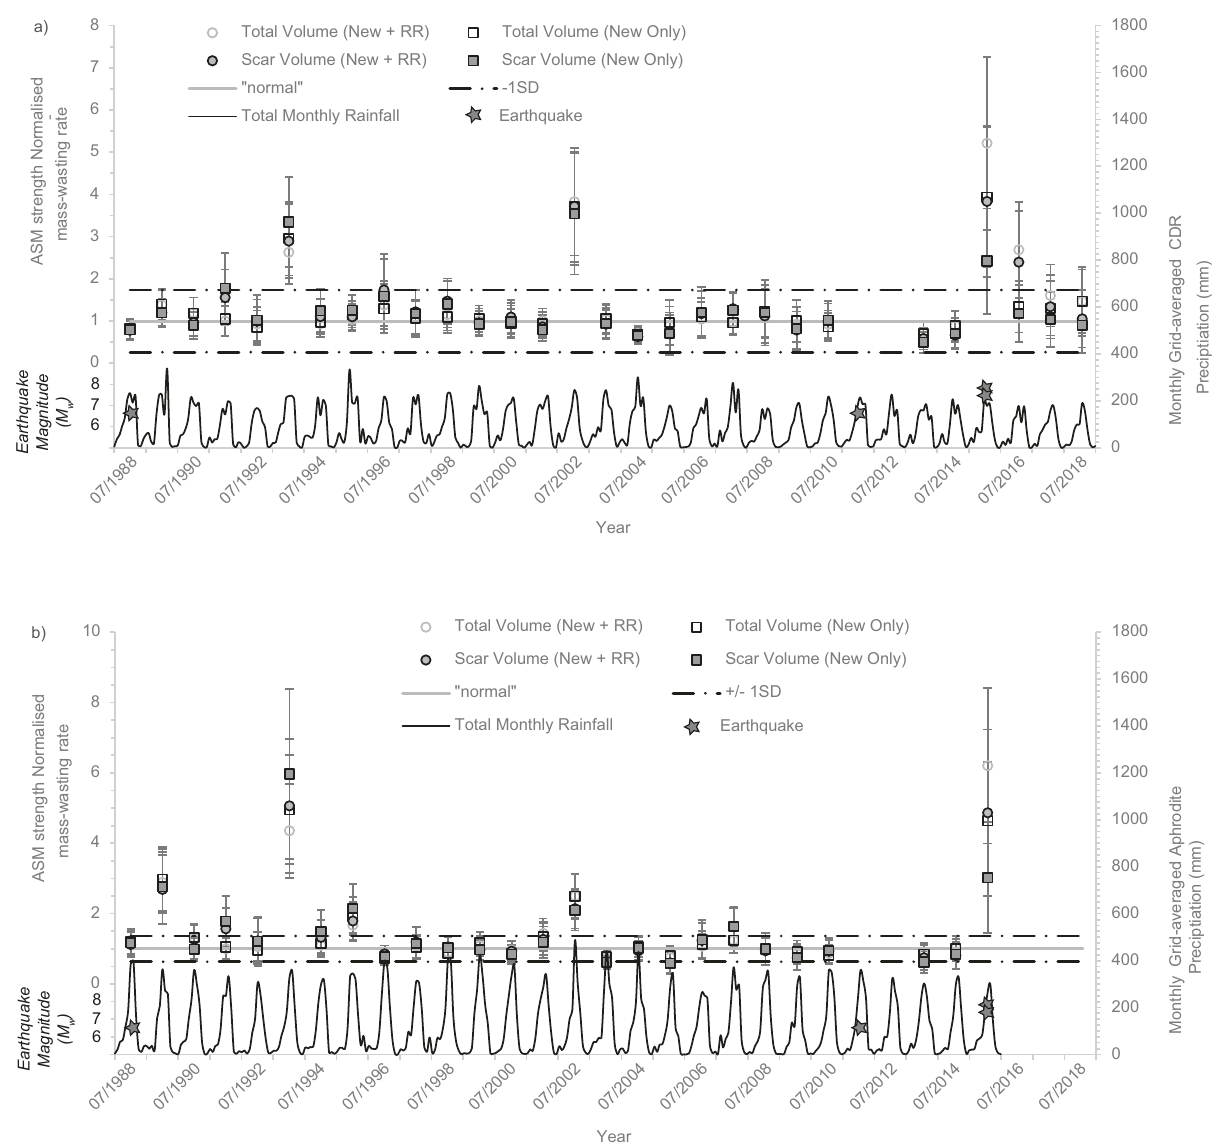
Fig. 3 ASM strength-normalised rates of mass-wasting between 1988 and 2018. These rates are shown for a the normalisation using the PERSIANN- CDR data and total MJJAS precipitation and b the normalisation using the APHRODITE data and total MJJAS precipitation >25 mm. In both cases, most years fall within a narrow window around the normal, with perturbations in 1993, 2002 and 2015 in ( a ), and 1989, 1993, 1995, 2002 and 2015 in ( b ). The occurrences of historical M w > 6.0 earthquakes are shown. Also depicted are the monthly grid-averaged PERSIANN-CDR ( a ) and APHRODITE ( b ) precipitation totals across the study region between 1988 and 2018. The errors in the normalised rate include the standard error in the data points used to calculate the prediction equations in Fig. 2, an assumed standard deviation of 20% on the mapped mass-wasting feature areas, and the standard deviations reported in the Larsen et al. 29 area – volume conversion parameters. Assuming that these errors are uncorrelated, they were combined using standard Gaussian propagation to obtain the fi nal error bar